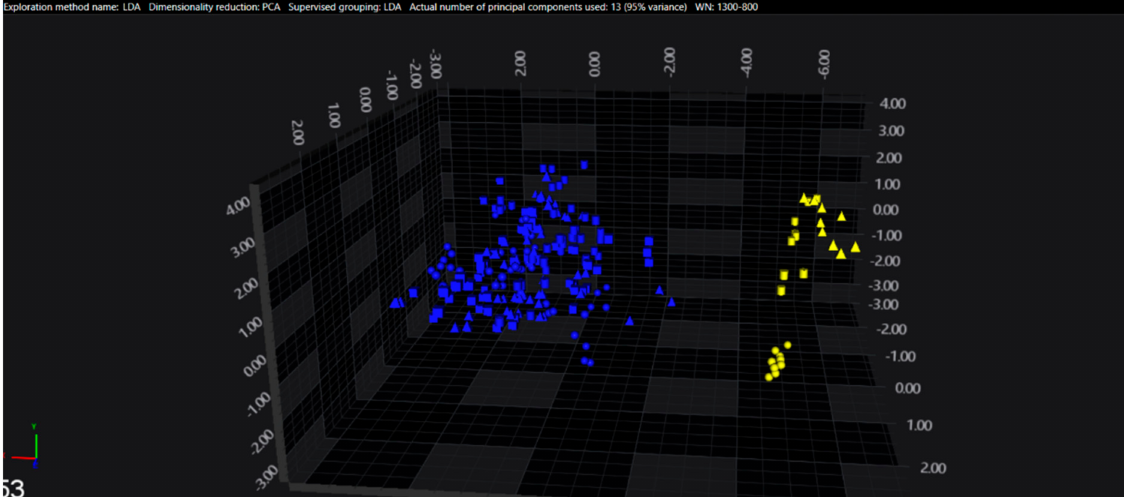
Figure 5. LDA of the O:2 serogroup (blue = Paratyphi A, yellow = other